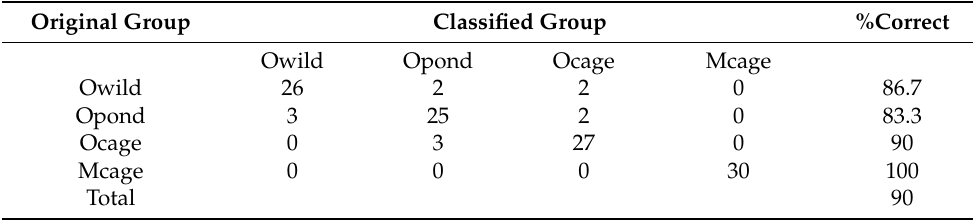
Table 2. Classification accuracy (by production method) of the random forest classification based on the elemental fingerprints of Sparus aurata collected at the four sampling origins as follows: Olh ã o–wild (Owild), Olh ã o–aquaculture in earth ponds (Opond), Olh ã o–sea-cage aquaculture (Ocage) and Madeira–sea-cage aquaculture